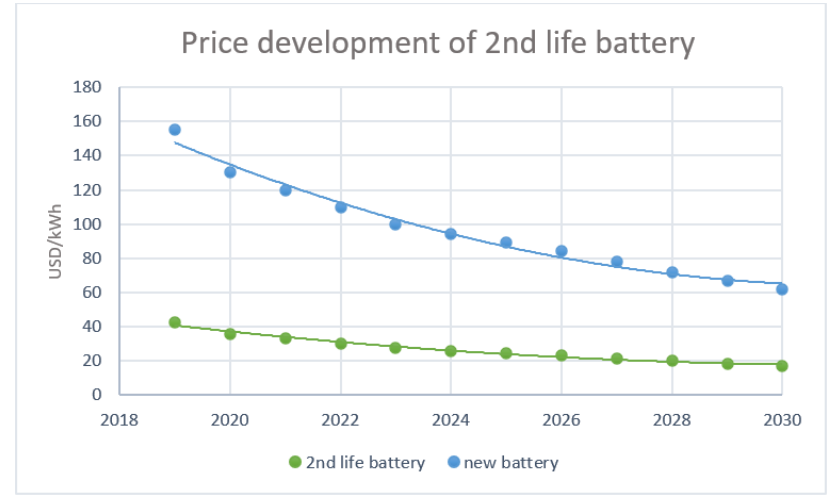
Figure 4. Price development of 2nd life battery.